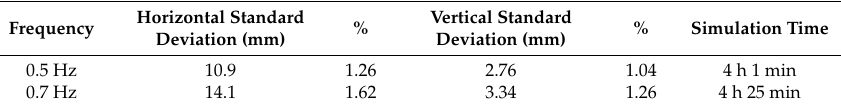
Table 6. Model output for the center of gravity ( Test 3 ).